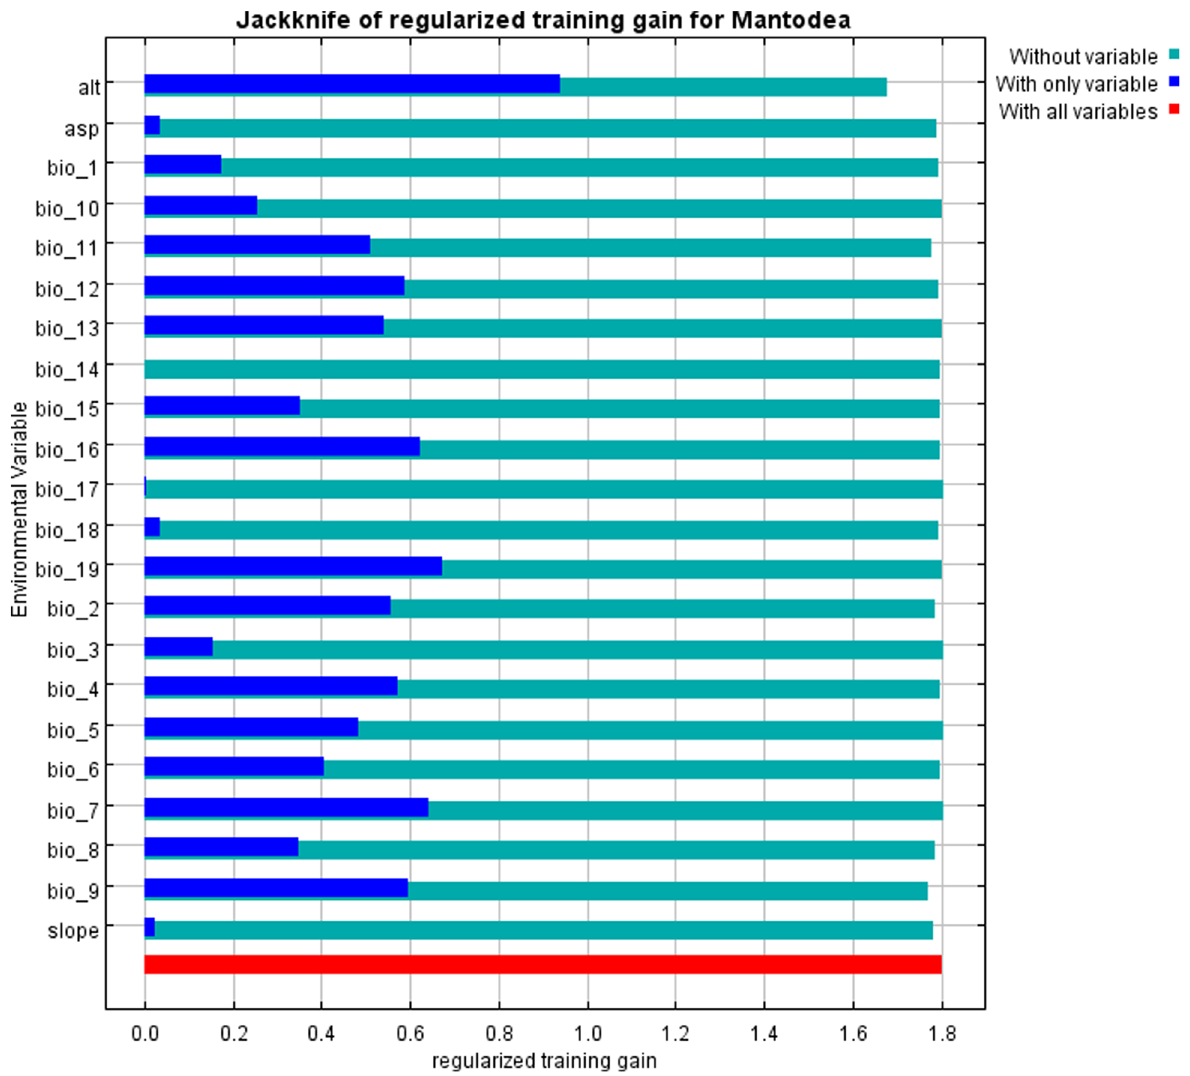
Fig. 4 Relative importance of environmental variables based on jackknife of regularized training gain in maxent model for Mantodea species, values shown are average over 20 replicate